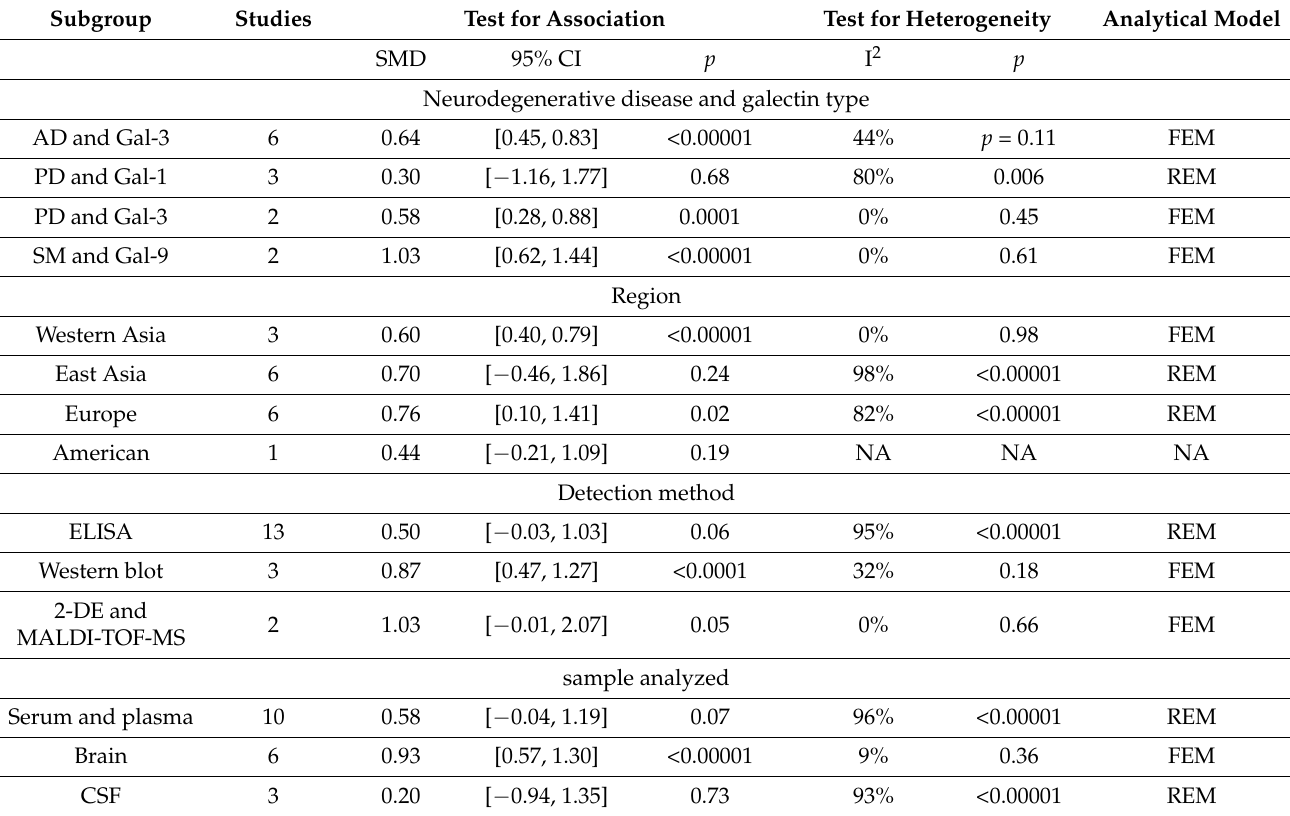
Table 2. Subgroup analysis of galectin expression levels in neurodegenerative